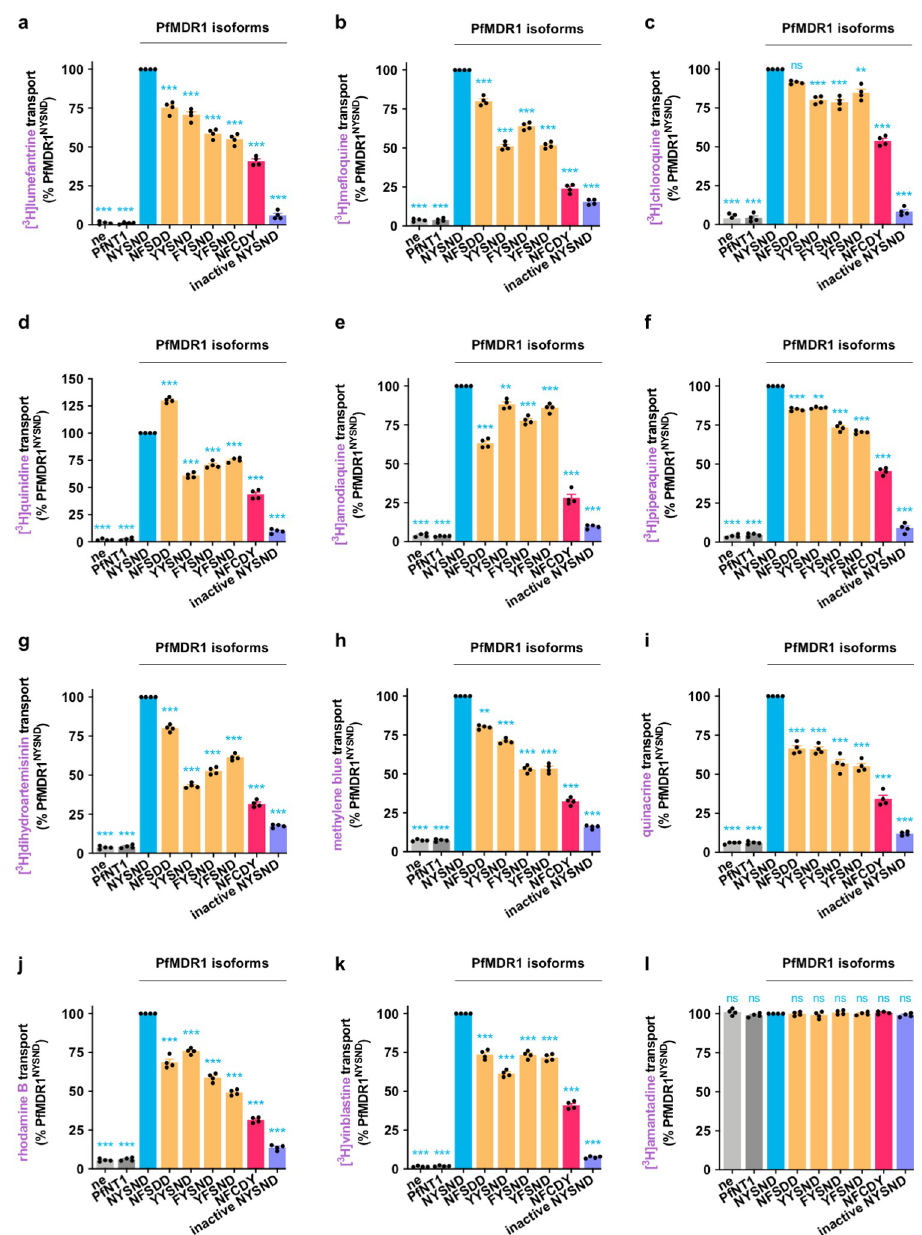
Fig 2. Field isoforms of PfMDR1 differ significantly in their capacities for antimalarial drug transport. (a–i) Field isoforms of PfMDR1 transported the antimalarial drugs [ 3 H]lumefantrine (a), [ 3 H]mefloquine (b), [ 3 H]chloroquine (c), [ 3 H]quinidine (d), [ 3 H]amodiaquine (e), [ 3 H]piperaquine (f), [ 3 H]dihydroartemisinin (g), methylene blue (h), and quinacrine (i). (j–l) All of the field isoforms of PfMDR1 also transported the human P-gp substrates rhodamine B (j) and [ 3 H]vinblastine (k), but none transported [ 3 H]amantadine (l). The transport of methylene blue, quinacrine, and rhodamine B was detected using the intrinsic fluorescence of these compounds and a fluorescence-based transport assay (see S2 Text). The data are the mean of n = 4 independent experiments (each yielding similar results and overlaid as individual data points), and the error is the SEM. The asterisks denote a significant difference from PfMDR1 NYSND ; � P < 0.05, �� P < 0.01, ��� P < 0.001, ns, not significant (1-way ANOVA). The data underlying this figure is supplied in S3 Data. ne, nonexpressing oocytes; PfMDR1, Plasmodium falciparum multidrug resistance protein 1.